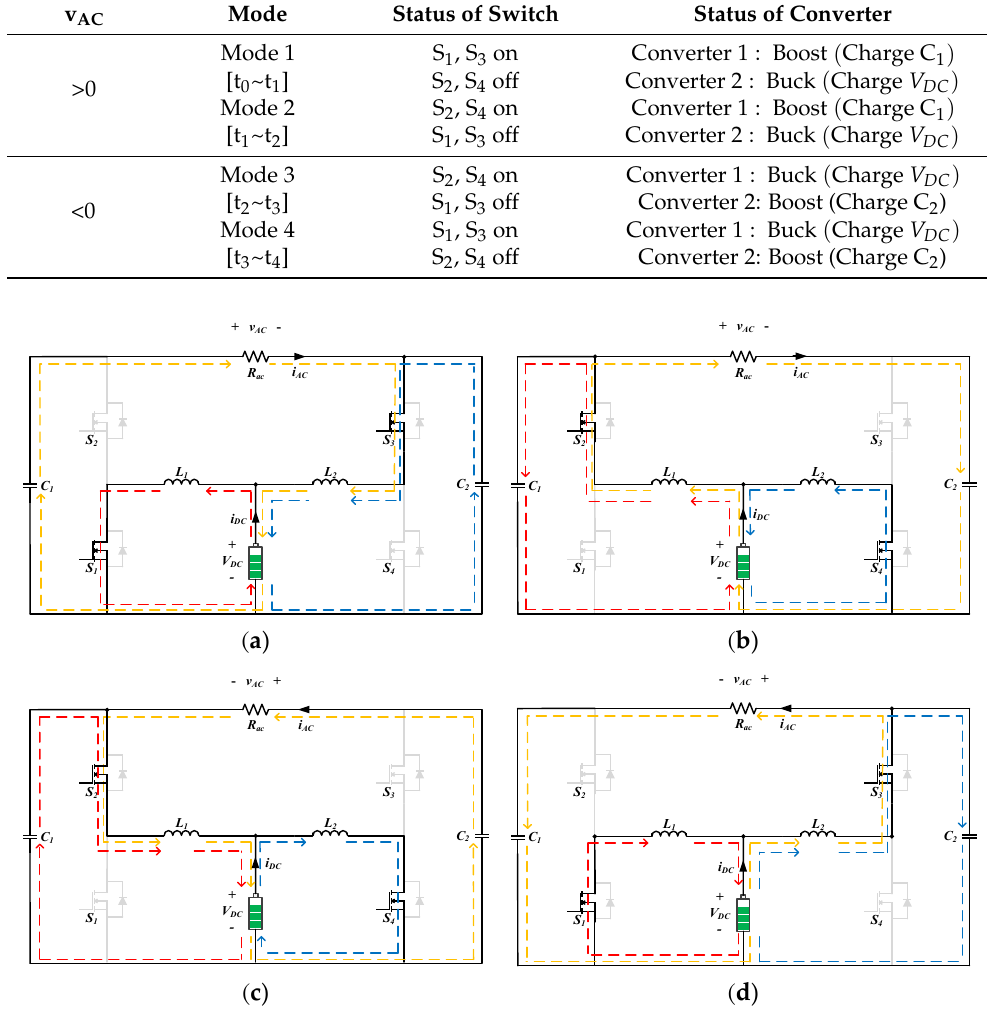
Figure 7. The operation states of the inverter: ( a ) Mode 1; ( b ) Mode 2; ( c ) Mode 3; ( d ) Mode 4. Mode 1 [t 0 ~ t 1 ]: